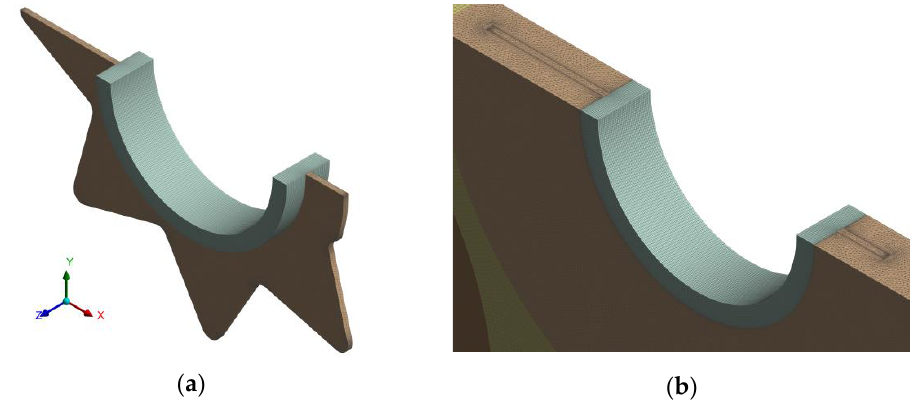
Figure 3. Three-dimensional view of the trimmed fin ( a ) and the mesh detail ( b ). Mesh independence analysis was performed, focused mainly on Nu and Eu . The results are shown in Figures 4 and 5.